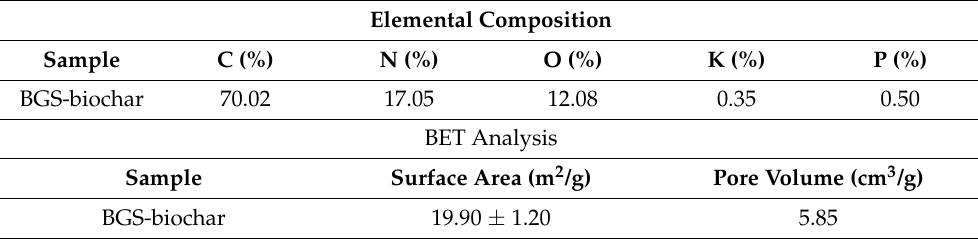
Table 1. Elemental composition and BET analysis of the BGS biochar. Elemental